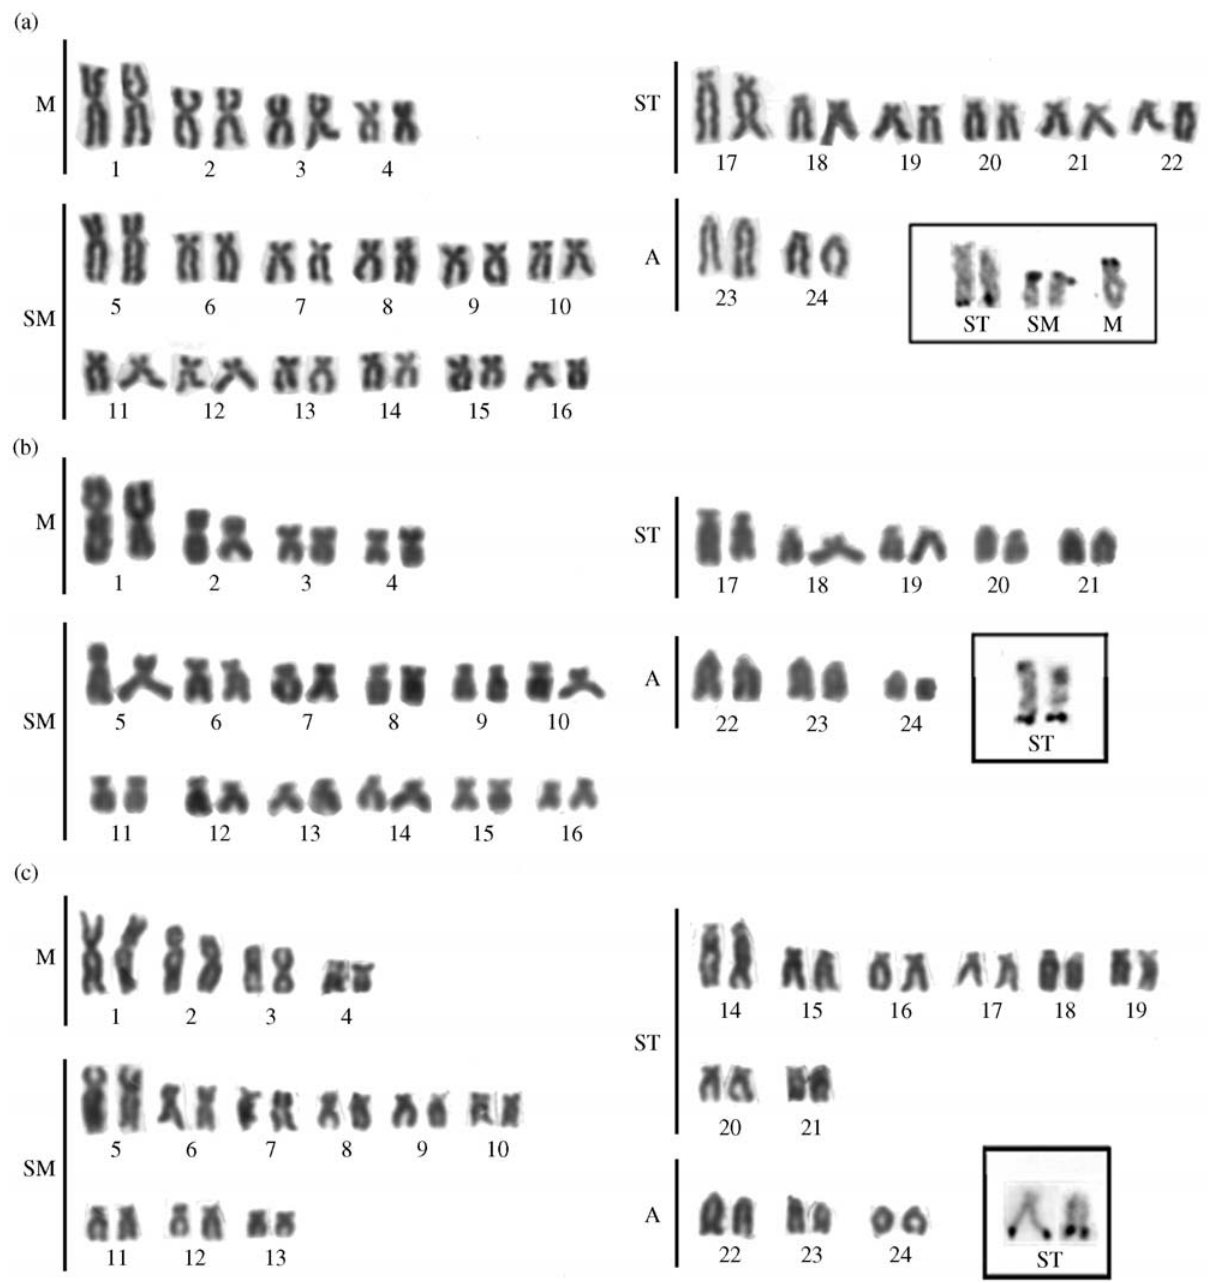
Figure 3 - Giemsa-stained karyotypes and NOR-bearing chromosomes after silver nitrate staining (inbox) of Astyanax fasciatus from Contas River (a), Preto do Costa River (b), and Mineiro Stream